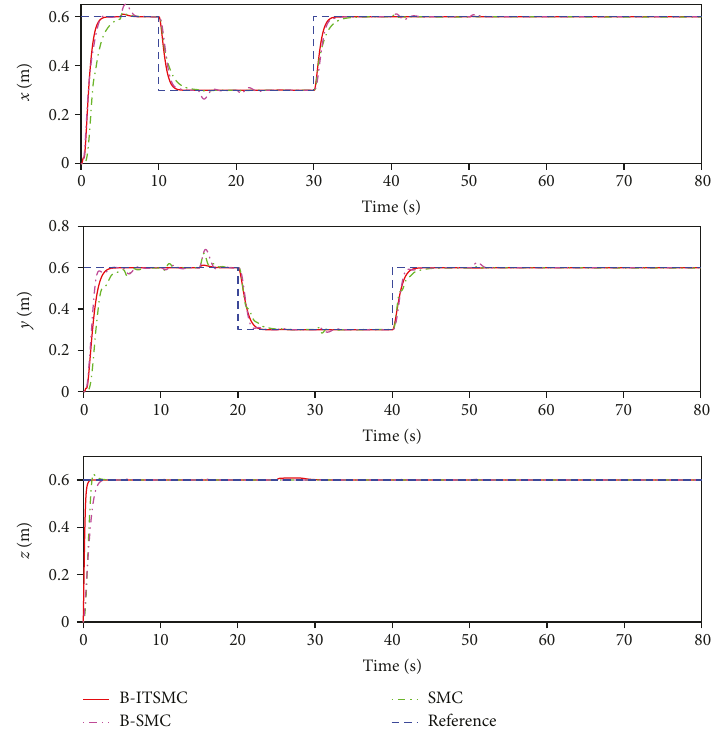
Figure 3: Response of quadrotor position.